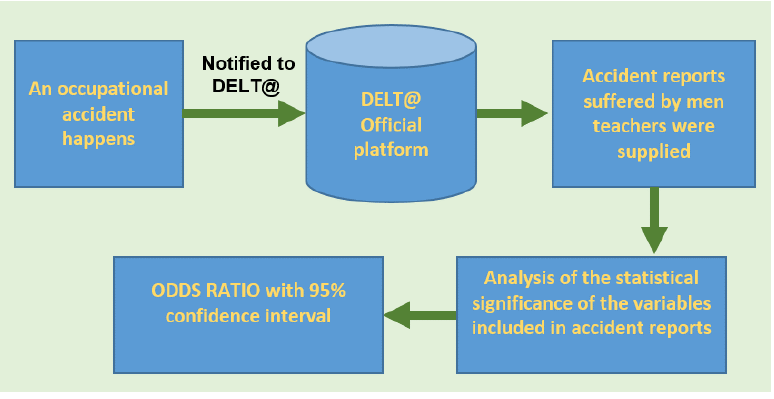
Figure 1. Description of the methodological